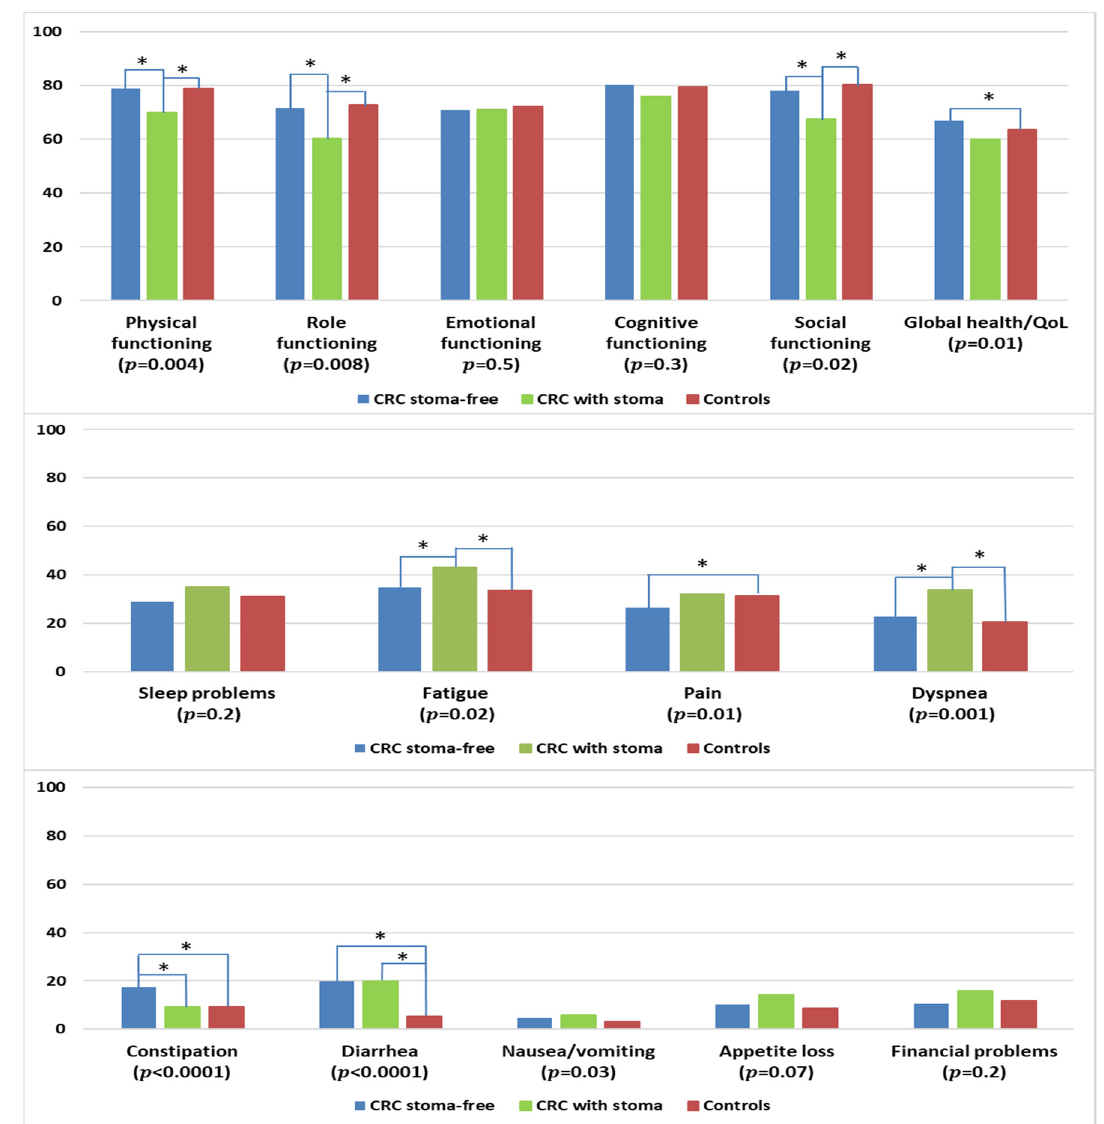
(Figure 6). Stoma-free survivors reported better global health/QOL than controls. CRC survivors with a stoma were more likely to report higher levels of fatigue and dyspnea when compared with colon cancer survivors and controls. Stoma-free CRC survivors reported less pain than controls but higher levels of constipation, in comparison with CRC survivors with permanent stoma or controls. CRC survivors, regardless of stoma status, reported more problems with diarrhea than controls.